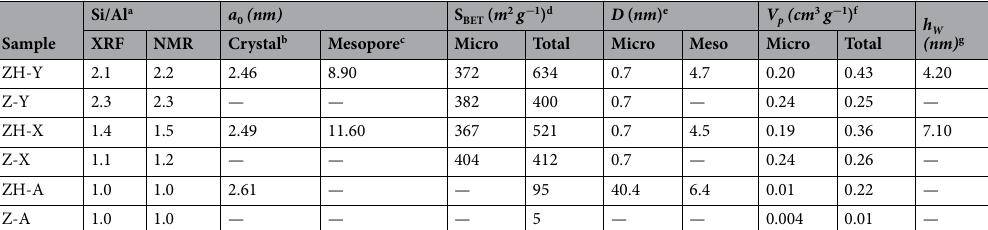
Table 1. Physicochemical properties of various zeolites. a Si/Al ratio determined from 29 Si MAS-NMR; b Crystal lattice constant by Rietveld refinement; c Mesopore structure lattice constant calculated using 1/d 2 = 4/3 (h 2 + hk + k 2 /a 2 ); d BET surface area; e Micro and mesopore size by HK and BJH methods; f Pore volume; g Mesopore-wall-thickness, h w = a 0 – D BJH .